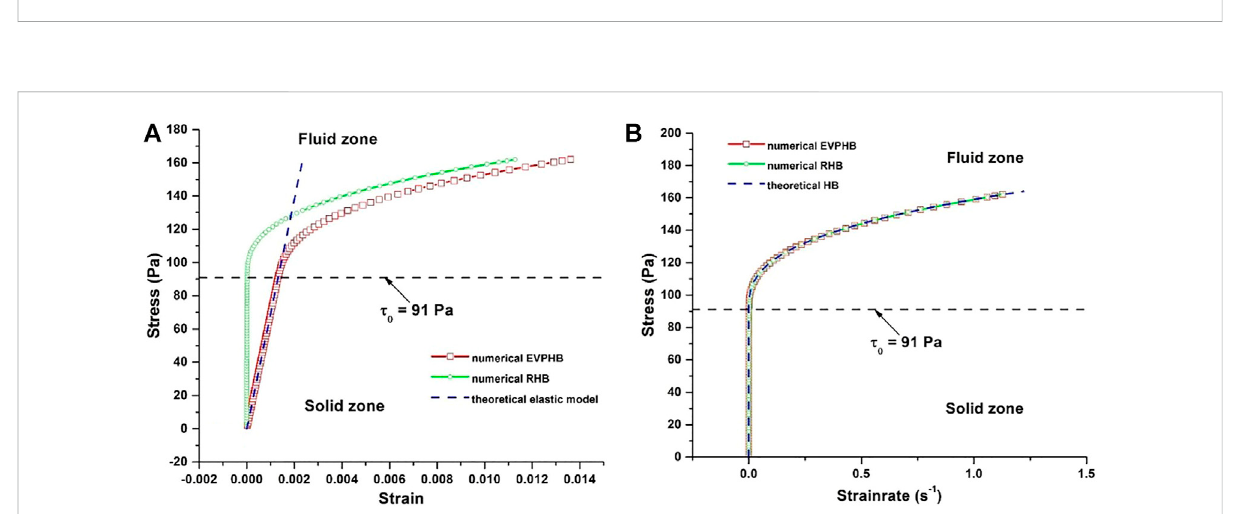
FIGURE 8 (A) Stress and strain relation in depth direction, (B) Stress and shear strain rate relation in depth